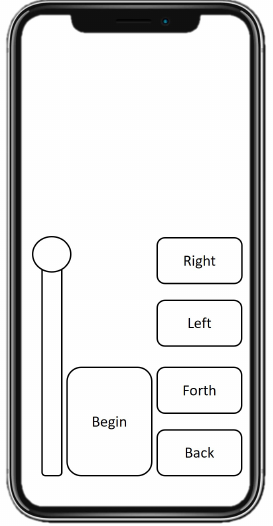
Figure 16. Mock-up for the augmented reality